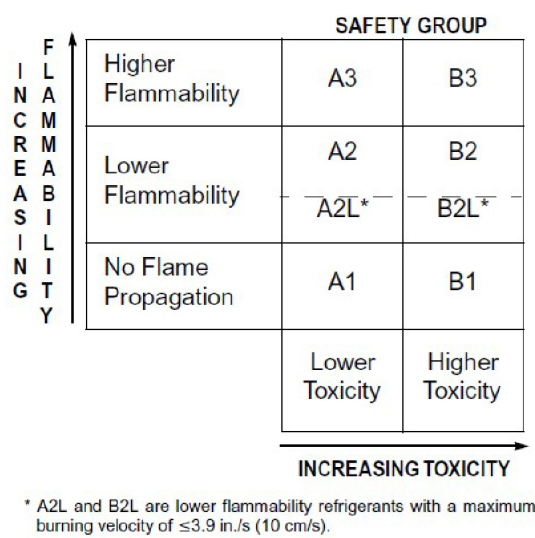
Figure 3. Classification of refrigerants with respect to their flammability and toxicity according to ASHRAE. Reprinted with permission from Ref. [13]. 2004, ASHRAE.